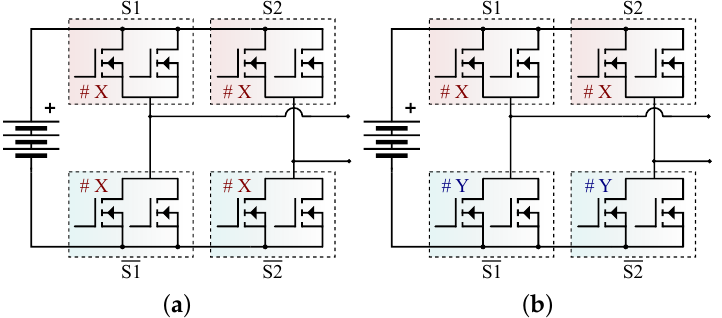
Figure 6. Inverter part number configuration for DM. ( a ) Scenario where all MOSFETs have the same part number. ( b ) Scenario where different part numbers are considered for the different switching